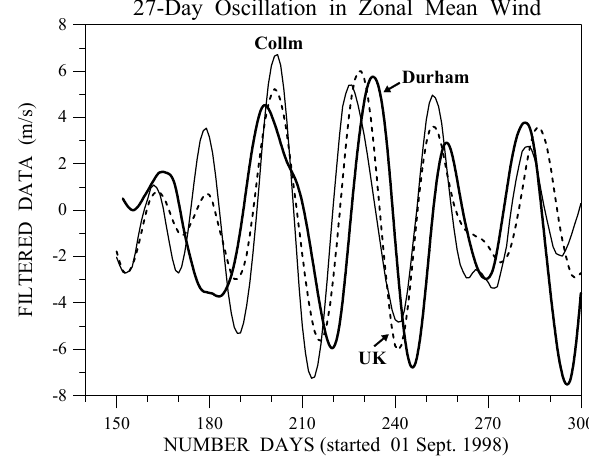
Fig. 3. The band-pass filtered zonal mean winds measured in Durham (thick solid line), Collm (thin solid line) and UK (dashed line). The filter is centred at period of